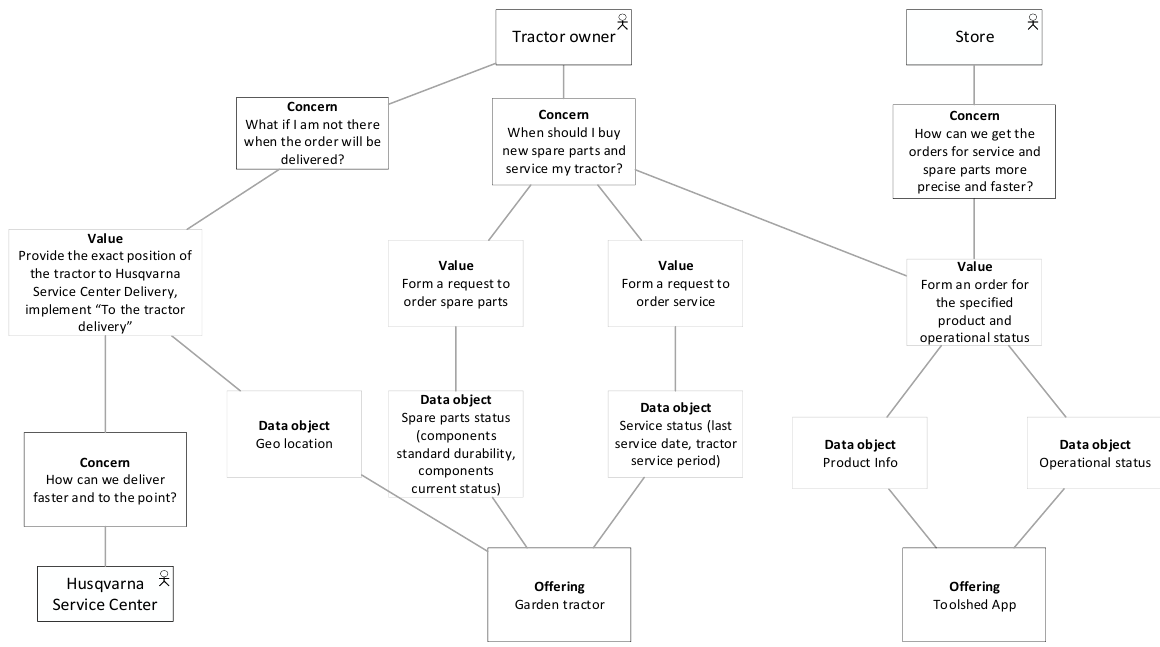
Figure 15. Data-driven business options – business actors and their concerns in relation to the offerings and the produced data